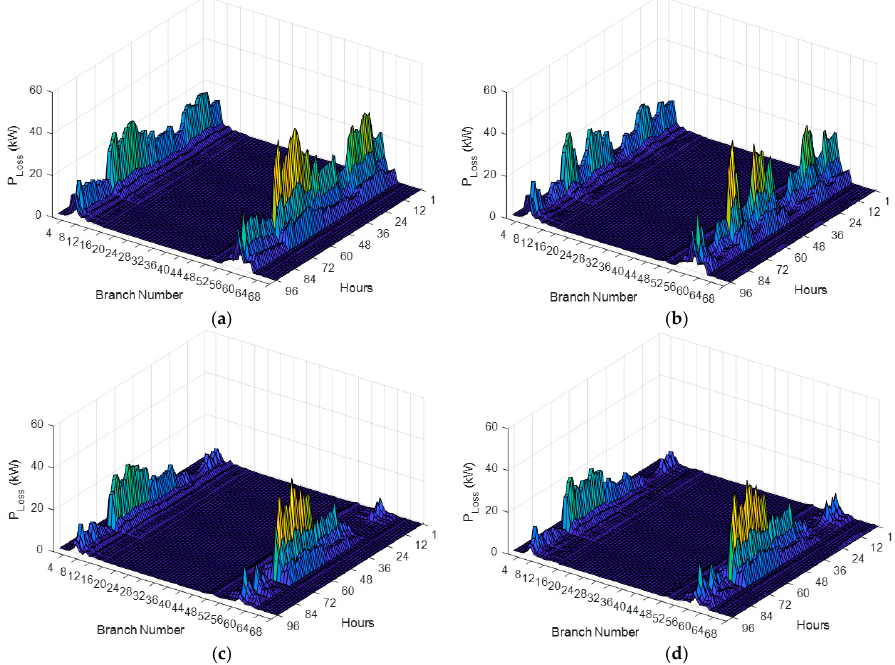
Figure 12. Seasonal branch active power loss variation for the IEEE 69-bus: ( a ) Basic case; ( b ) PVDG case; ( c ) WTDG case; ( d ) Hybrid PVDG-WTDG case. The optimal installation of the studied cases using the MPA technique had an obvi- ous impact on seasonal active loss in every branch of test system EDNs as represented in the 3D graphics shown in Figures 11 and 12. It is proven that: the case of hybrid PVDG-WTDG units was the best choice that re- vealed a strong impact of minimization in every branch of the two test system EDNs throughout the year’s seasons and especially in the winter season, for the reason that the WTDG units provide huge and maximum generation of both reactive and active powers and also are compensated and have the PVDG units as a backup and an additional source of energy even if it is not the best season for the PVDG to generate its maximum output power, but it is considered an essential element that contributed to those best results. Fig- ure 13 illustrates the seasonal total voltage deviation variation of both test system EDN represented in 96 h for all cases of optimal RDG presence. The results shown in Figure 13 confirm that the optimal presence of all the studied cases, based on using the MPA tech- nique, excellently affected and minimized the total seasonal voltage deviation in both test system EDNs.